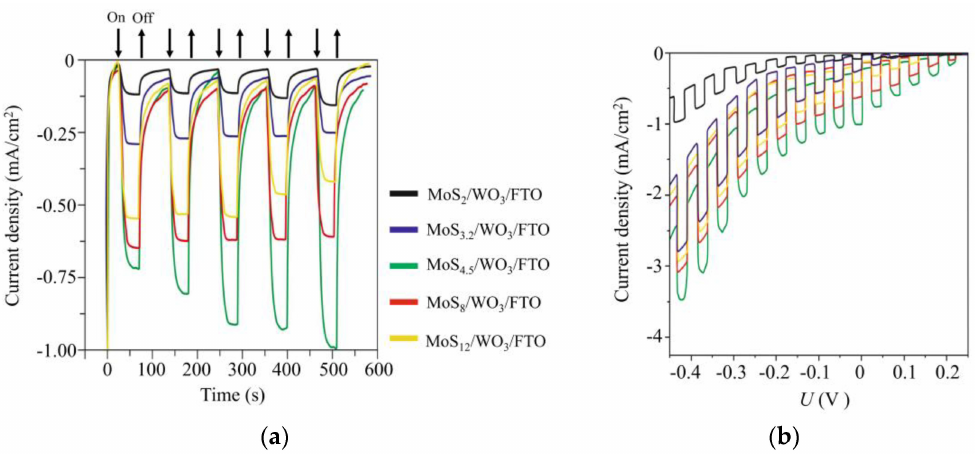
Figure 13. ( a ) Chopped (light / dark) chronoamperometry curves and ( b ) chopped linear sweep voltammetry (LSV) curves of MoS x / WO 3 / FTO photocathodes with a di ff erent stoichiometry of MoS x catalytic films. The curves were measured in a 0.5 H 2 SO 4 solution at an applied potential of ~0 V (RHE) under Xe lamp illumination (~100 mW / cm 2